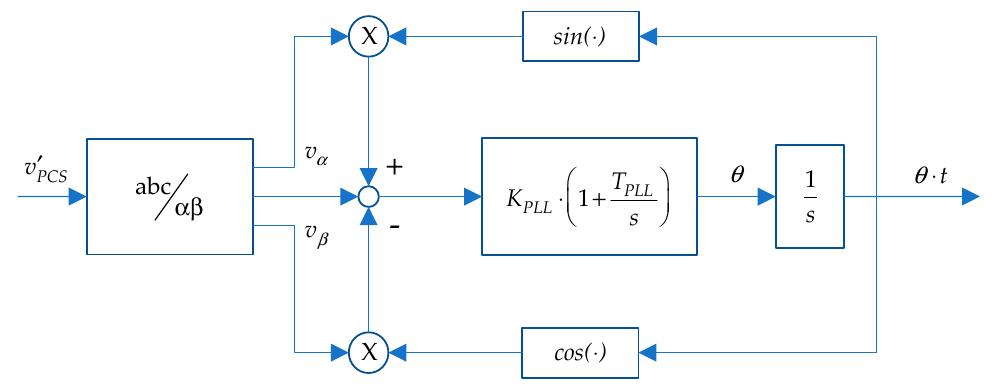
Figure 6. Phase-Locked Loop (PLL)